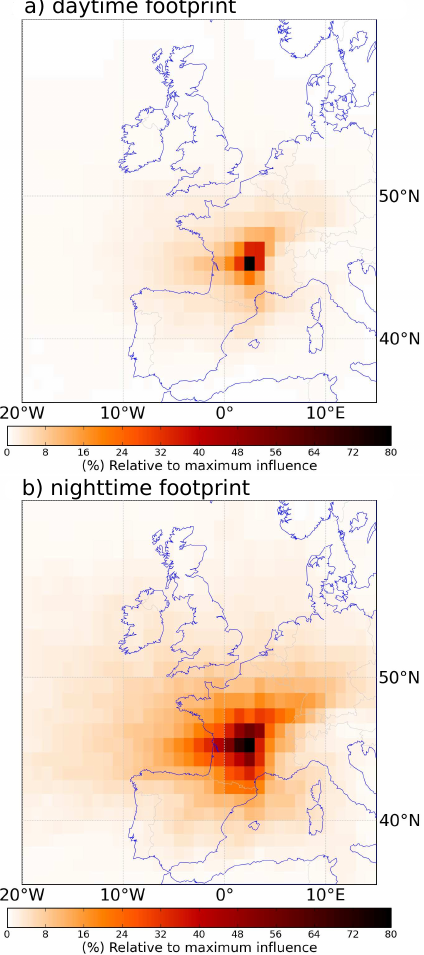
Figure 1. Footprint of the Puy de Dôme station from the Lagrangian dispersion model Flexpart (a) during daytime (14:00 to 16:00UTC), when the PBL is usually well developed, and (b) during nighttime (22:00 to 06:00UTC), when the station is usually in the free tropo-